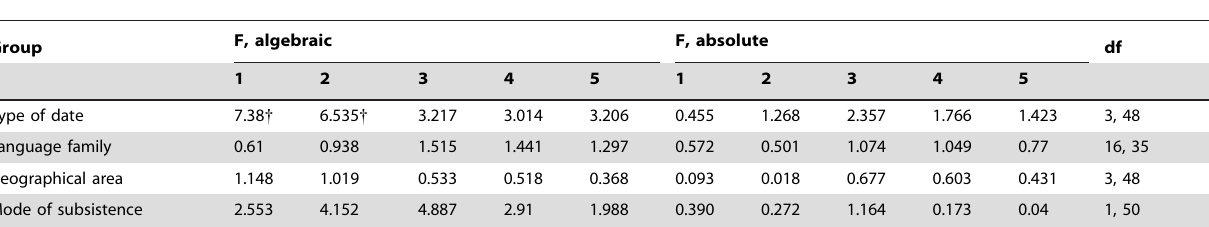
Table 2. F -score for algebraic and absolute percentage differences.